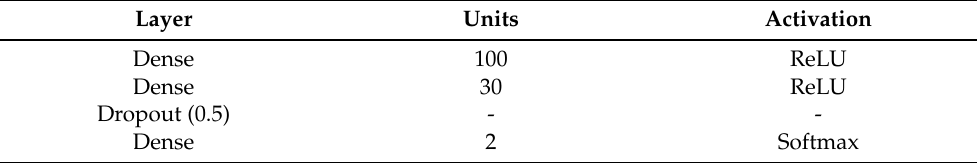
Table 5. Model architecture for the default of credicard clients dataset (Dense